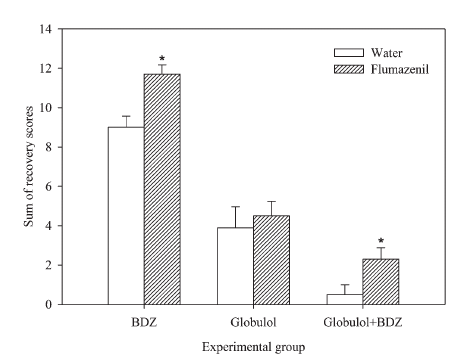
Figure 3. Sum of recovery scores for silver catfish exposed to 20 mg/L globulol, 150 m M benzodiazepine (BDZ), and the association (globulol+ +BDZ) at the same concentrations. Data are reported as means±SE (n =5). *P , 0.05, compared to treatment with water ( t